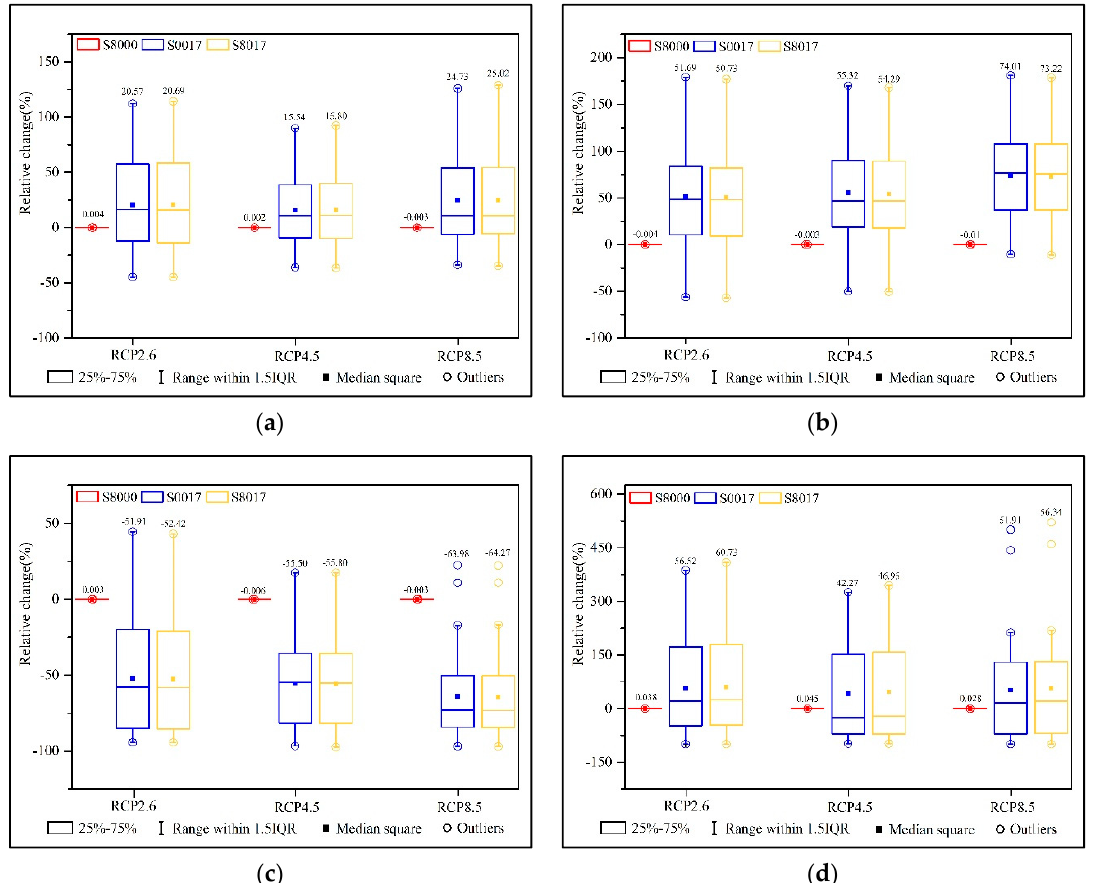
Figure 13. Boxplots of the relative change of ( a ) the annual runoff, and ( b ) runoff in the wet season (June, July, August, and September), and ( c ) the temperate season (April, May, October, and November) runoff, and ( d ) runoff in the dry season (January, February, March, and December) at Minhe station under three RCPs during 2021 – 2050. The number of each box represents the average value.